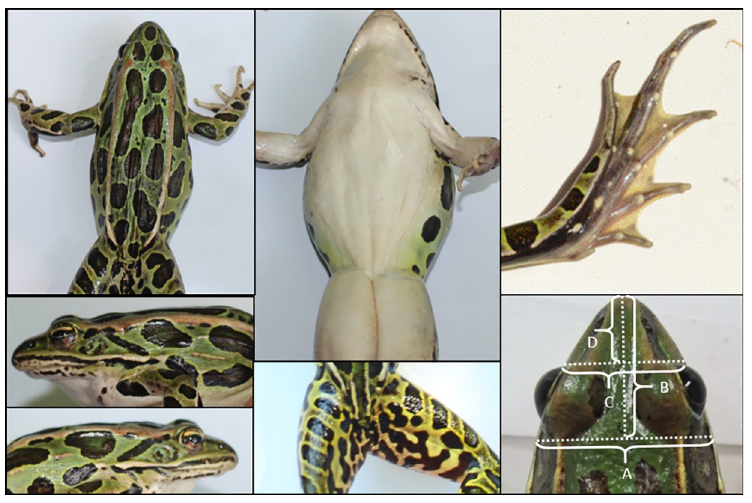
Fig 1. Example of photographs of a captured leopard frog taken from prescribed angles (clockwise from lower left): right side, left side, dorsal, ventral, femoral reticulum, hind foot; and photo measurements (lower right) of head width (A), head length (B), snout width (C), and snout length